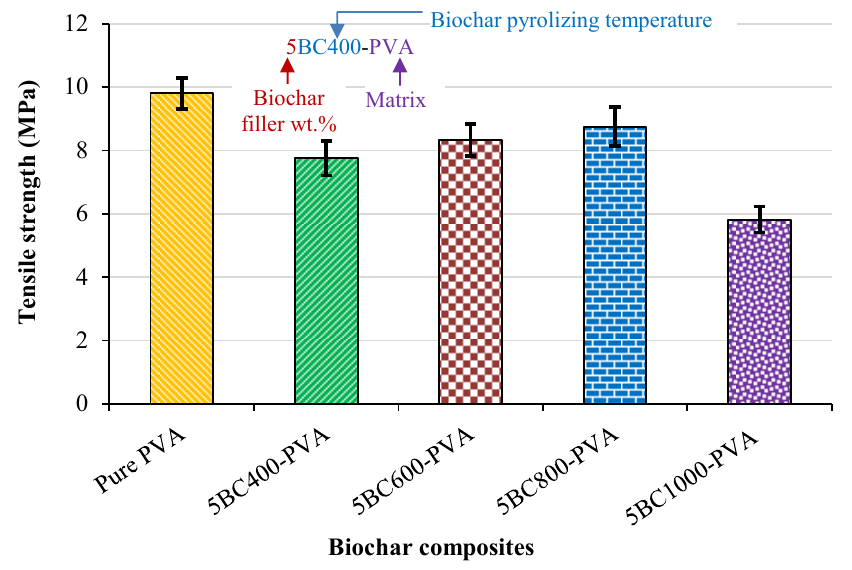
Figure 9. Effect of pyrolyzing temperature on the tensile strength of biocomposite films prepared with 5 wt.% biochar.